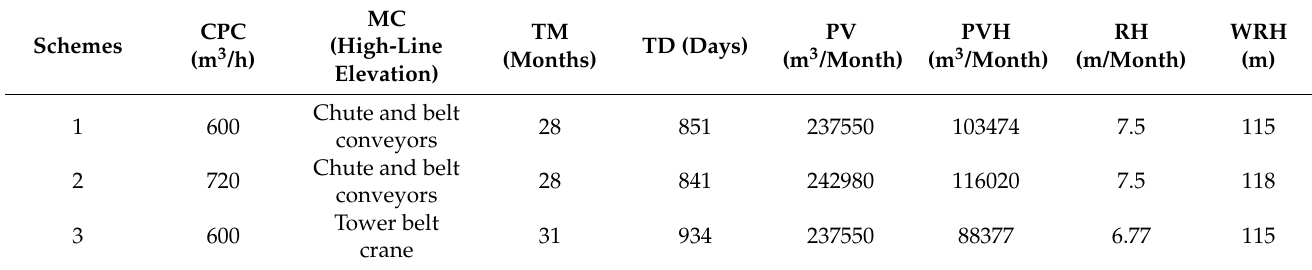
Table 10. Values of the progress attributes for the RCC gravity dam construction.